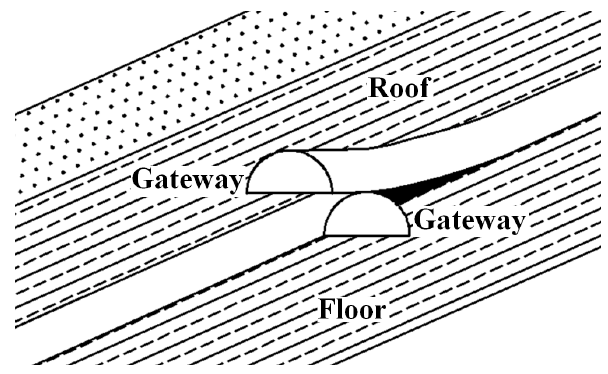
Figure 12. LMSG for thin coal seams.